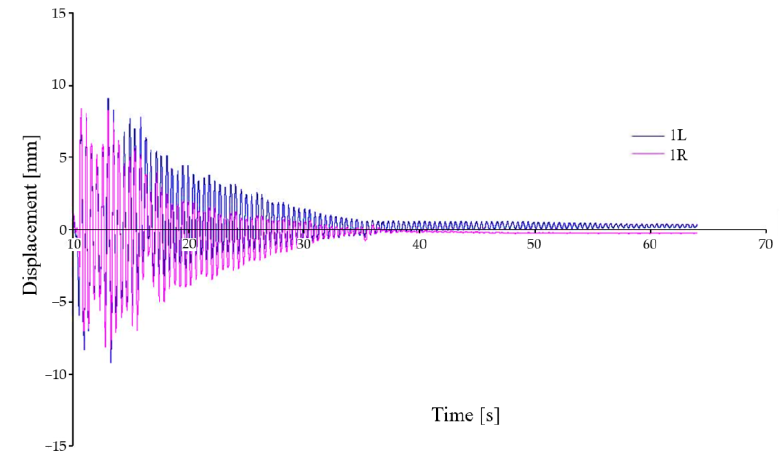
Figure 10. Relative vertical displacement between chassis frame and wheelset—variant A–I.